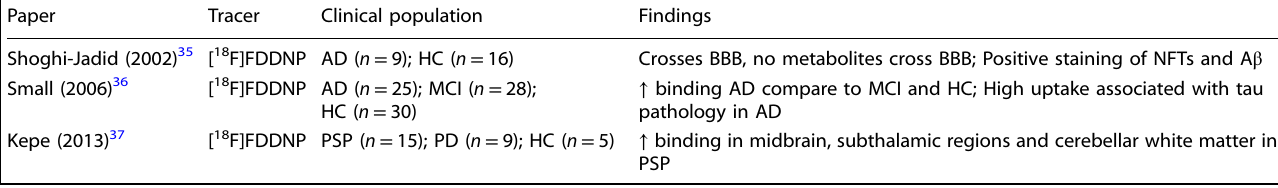
Table 1. Main fi ndings from PET tau studies using [ 18 F]FDDNP Paper Tracer Clinical population Findings